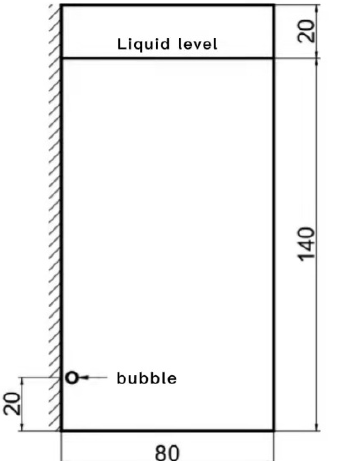
Figure 1. Two ‐ dimensional calculation domain of the near ‐ wall bubble with an initial diameter of 4 mm.